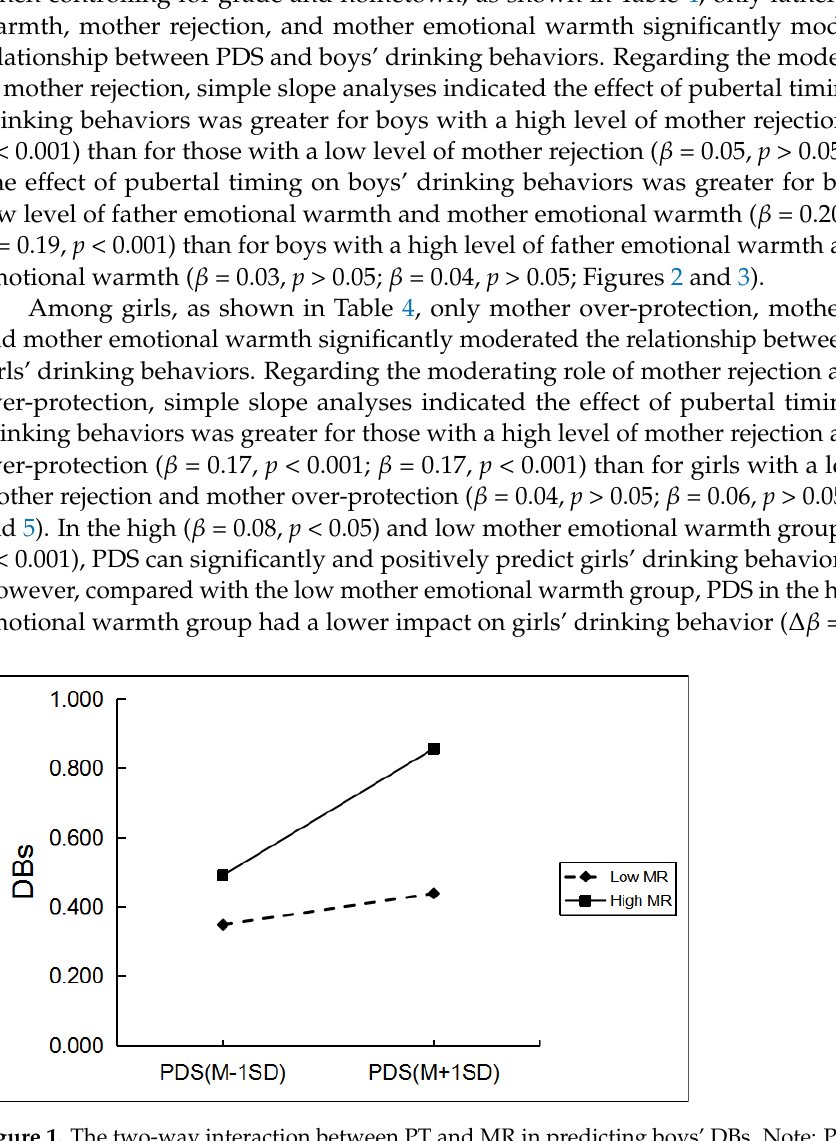
Figure 1. The two-way interaction between PT and MR in predicting boys’ DBs. Note: PDS, the total score of pubertal development scale; MR, mother rejection; DBs, drinking behaviors.